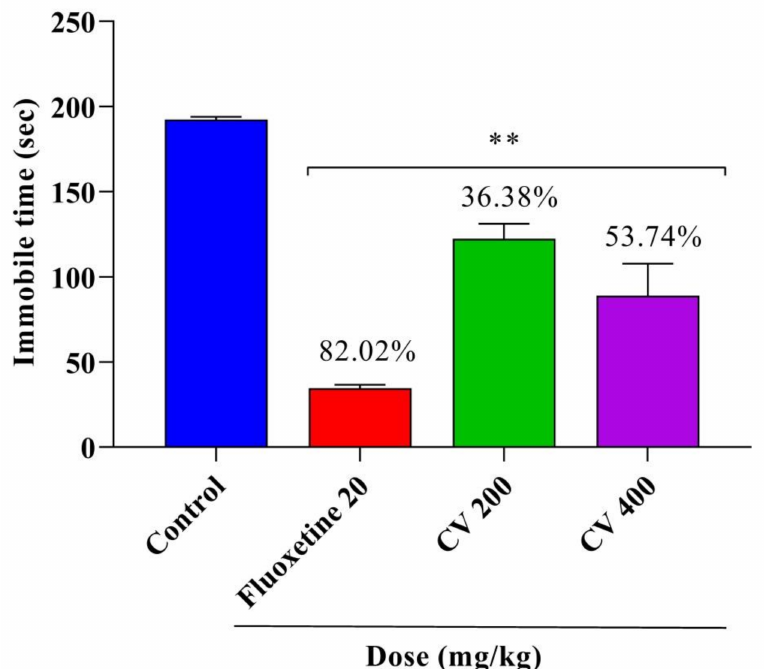
Figure 5. Antidepressant activities of the methanol extract of Cnesmone javanica (CV) and fluoxetine as assessed by the tail suspension test. Significant differences (** p < 0.001) were assessed using one-way analysis of variance (ANOVA, followed by Dunnett’s